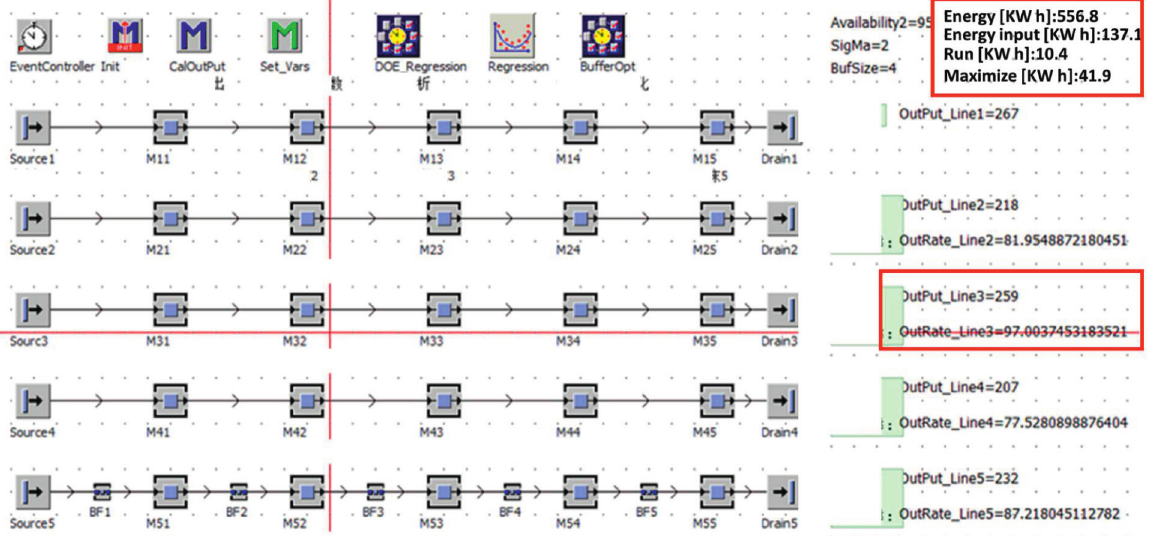
Figure 5: The result of the digital twin